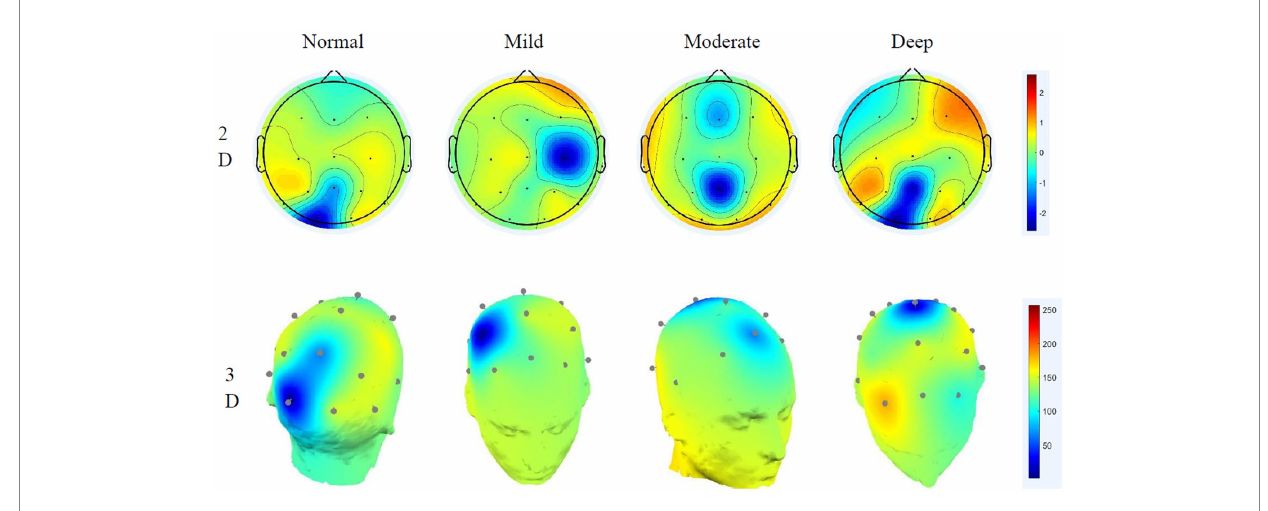
FIGURE 5 Delta wave 2D–3D EEG topography in different